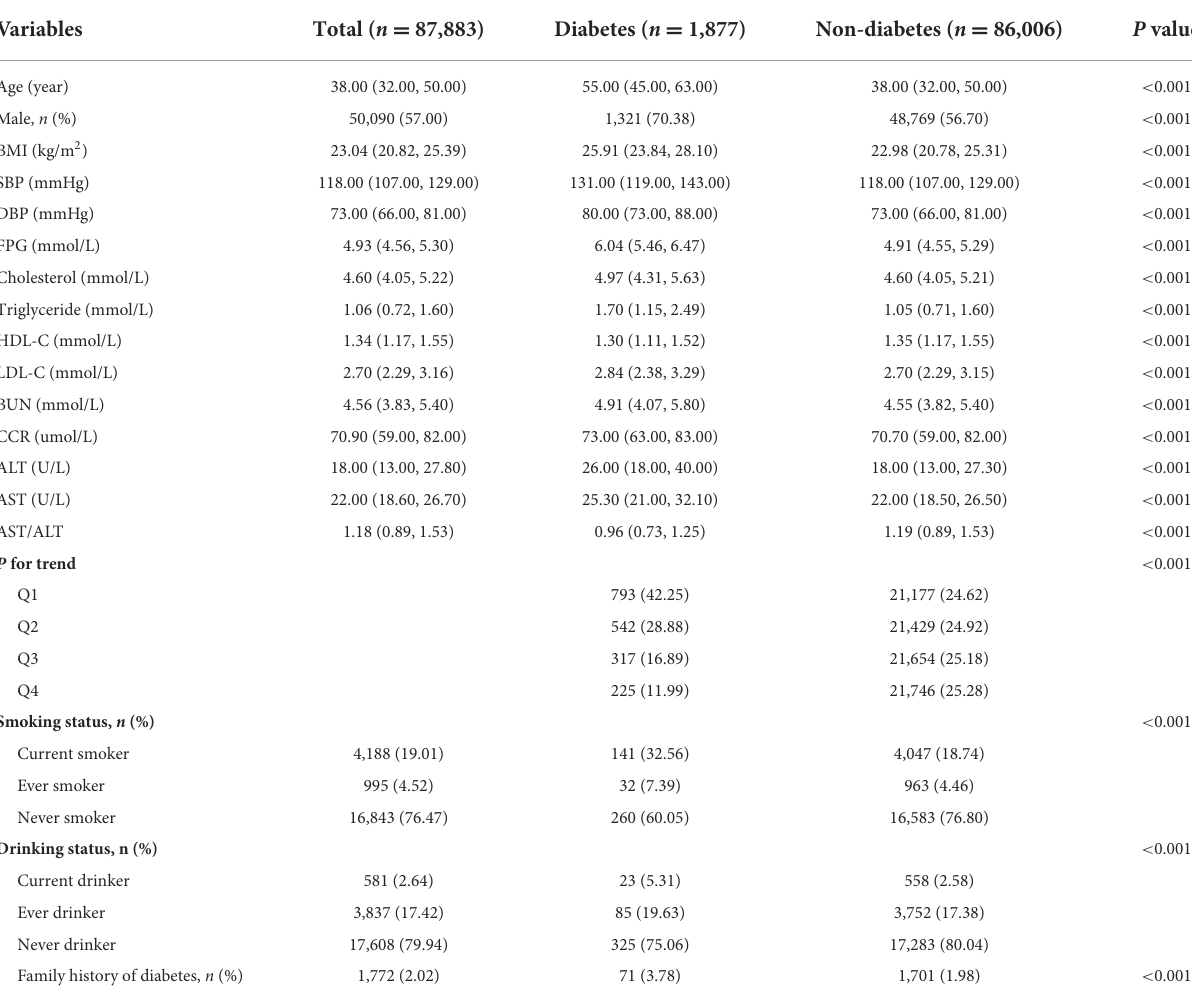
TABLE 1 Baseline characteristics of the study